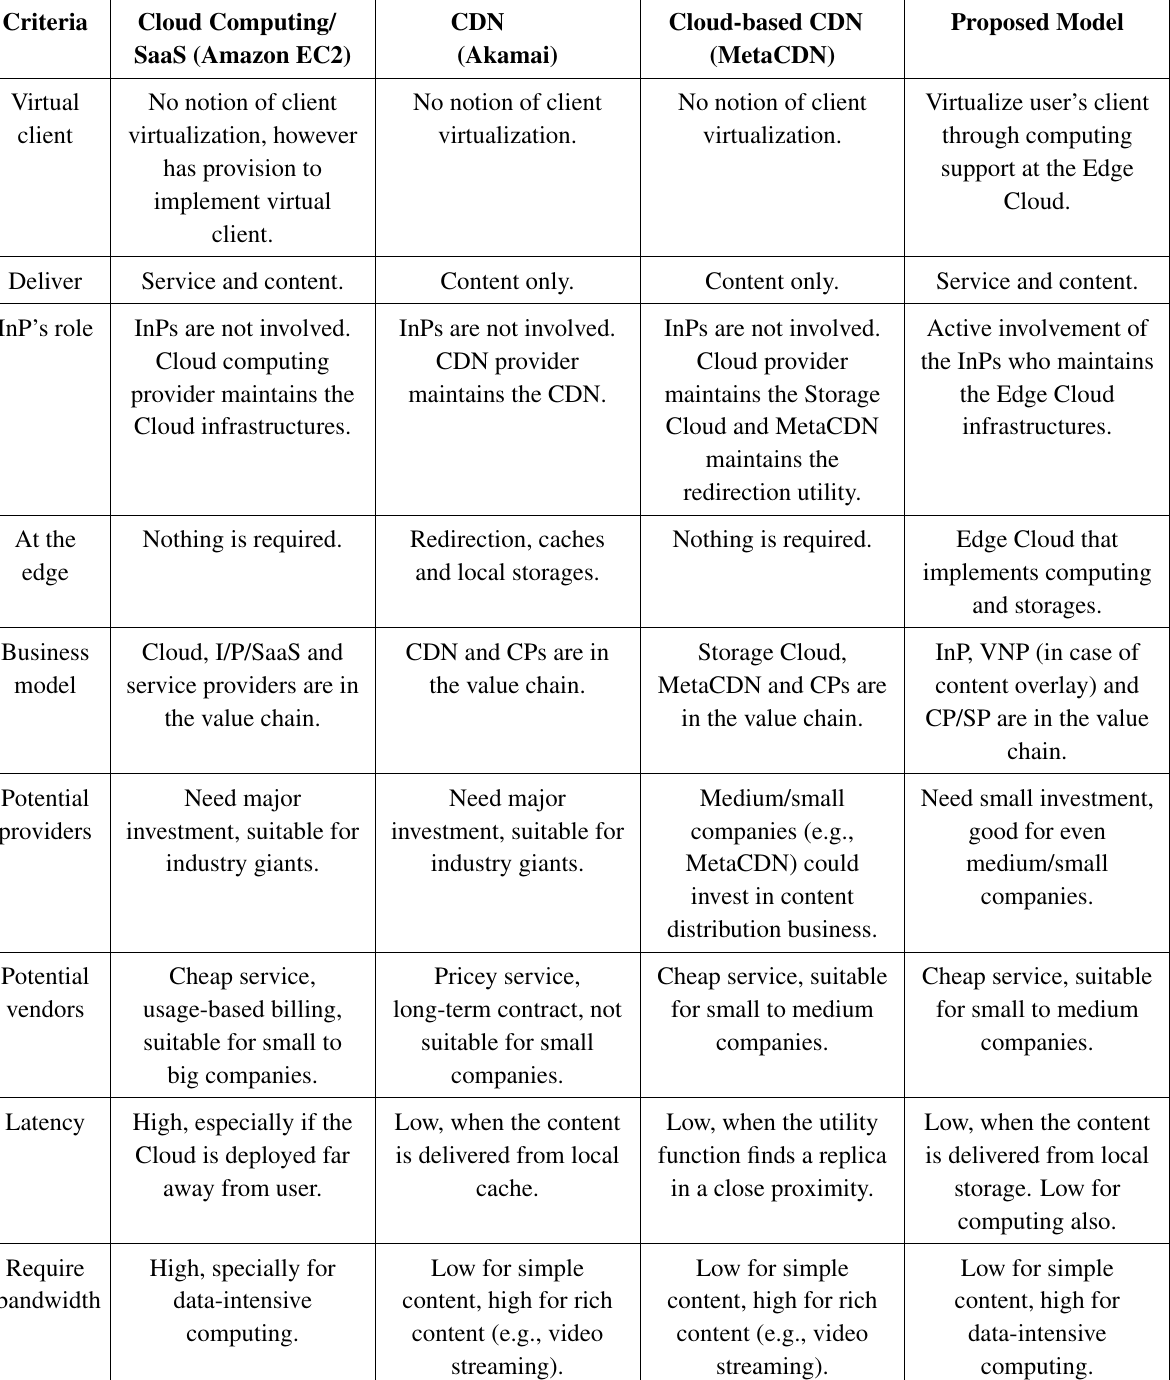
Table 1. Comparison of proposed model with existing content/service delivery models.